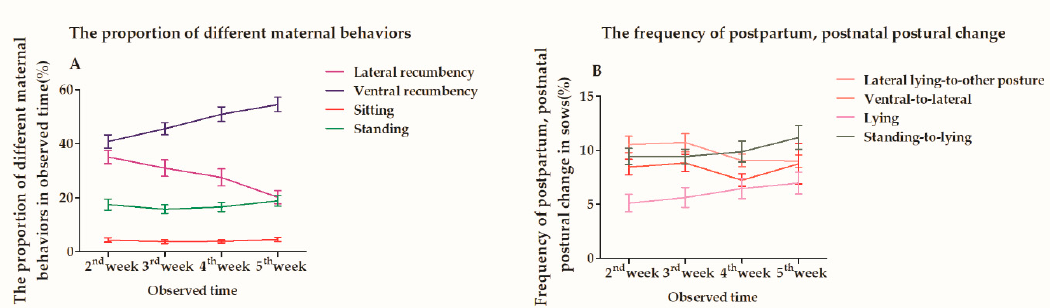
Figure 3. ( A ) Proportion of different maternal behaviors during the observed time from the second week to the fifth week postpartum in sows. ( B ) Frequency of postpartum, postnatal postural change in sows.